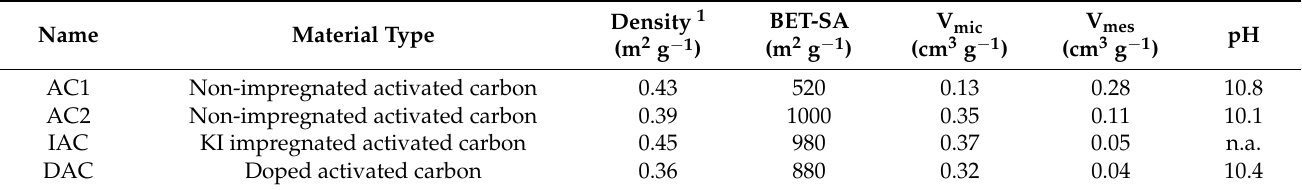
Table 1. Activated carbon materials and their measured density, specific surface area, pore volume, and surface